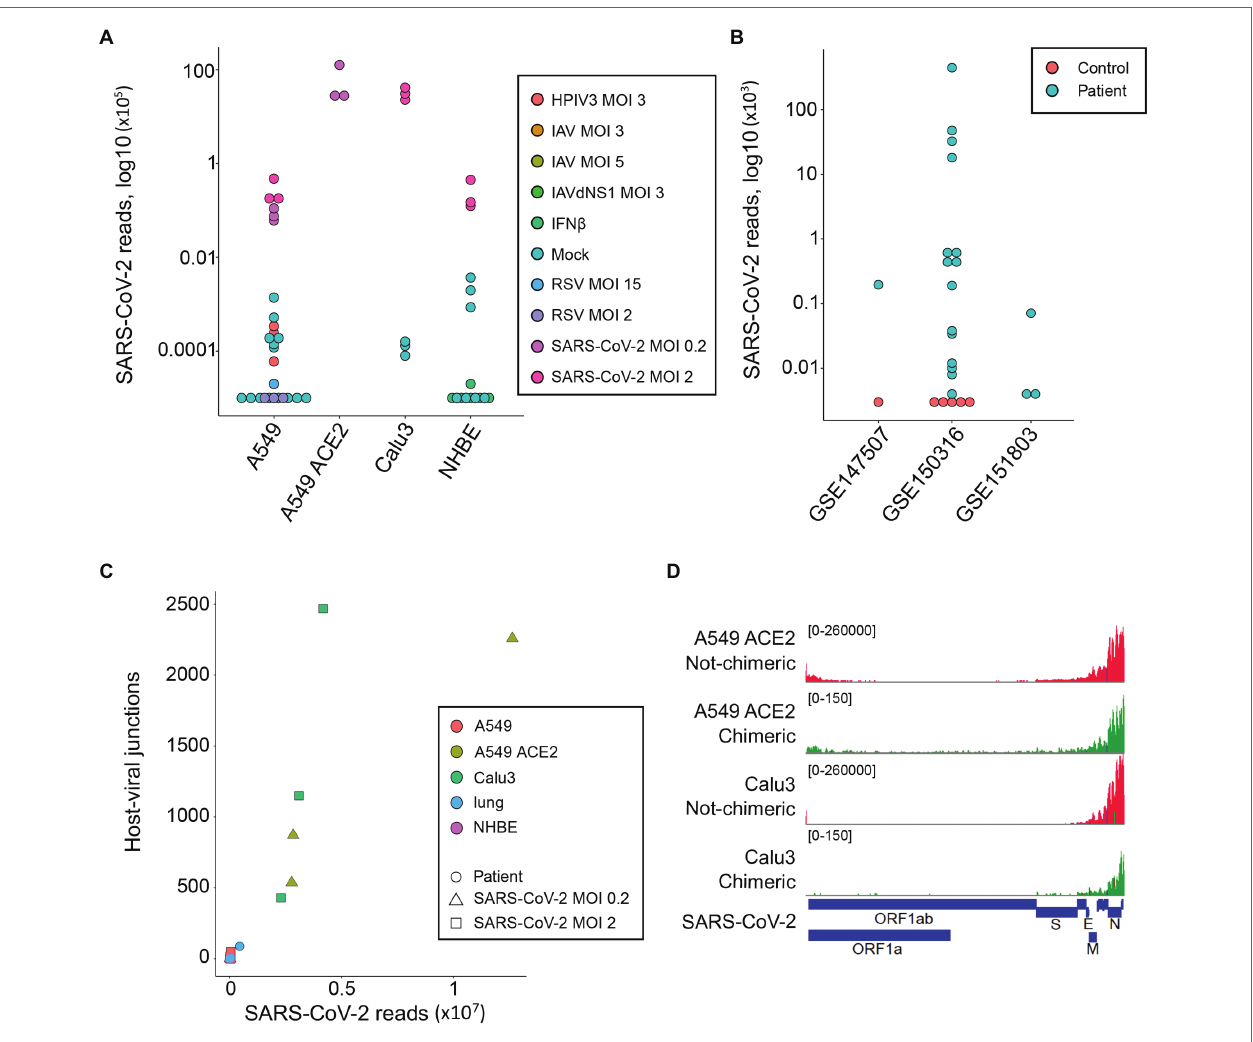
( Figure 1A ). Minimal numbers of SARS-CoV-2-mapping reads (median = 0, range 0–370) were identified in uninfected cell lines or those infected with unrelated viruses